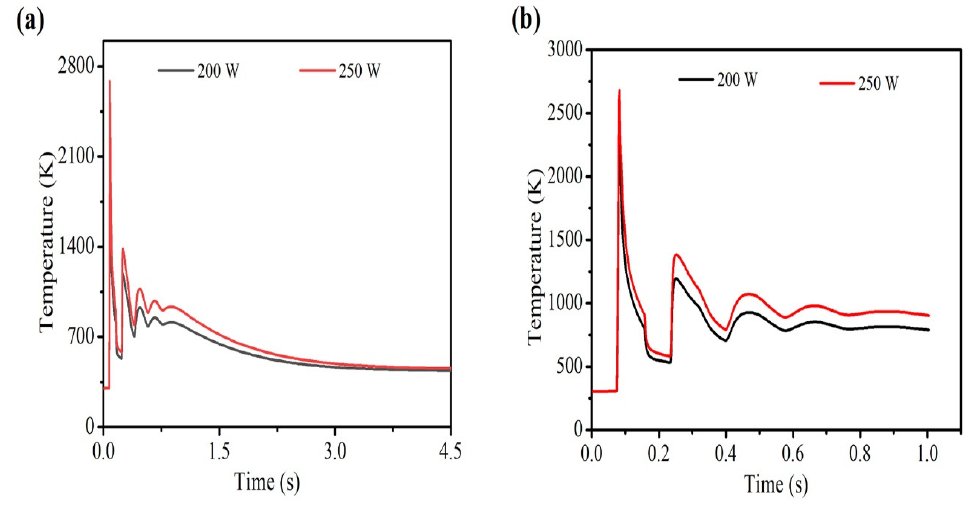
Figure 9. Effect of laser power in the middle of the 1st layer when laser power is 200, 250 W and scan speed is 200 mm · s − 1 ( a ) full view and ( b ) magnified view.